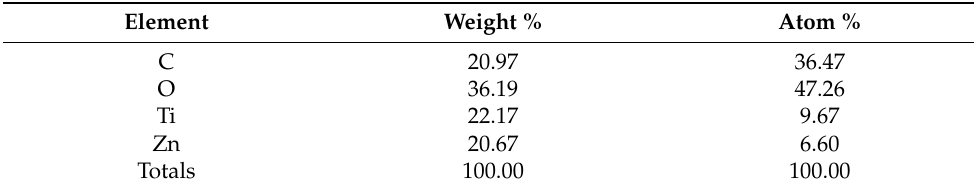
Figure 3. SEM images of ( a ) ZnO-TiO 2 , ( b ) GO, and ( c ) ZnO-TiO 2 -rGO. ( d ) Element content of ZnO-TiO 2 -rGO. Table 1. Element content of ZnO-TiO 2 -rGO.